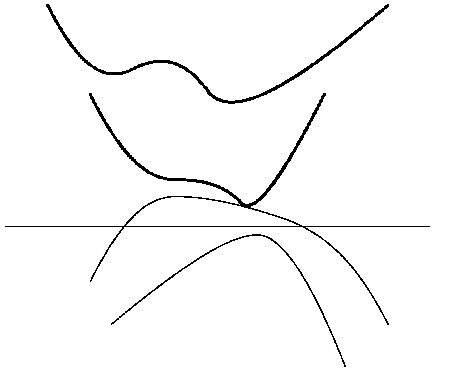
Figure 10 . Possible con(cid:12)guration of singular loci when there is no k 1